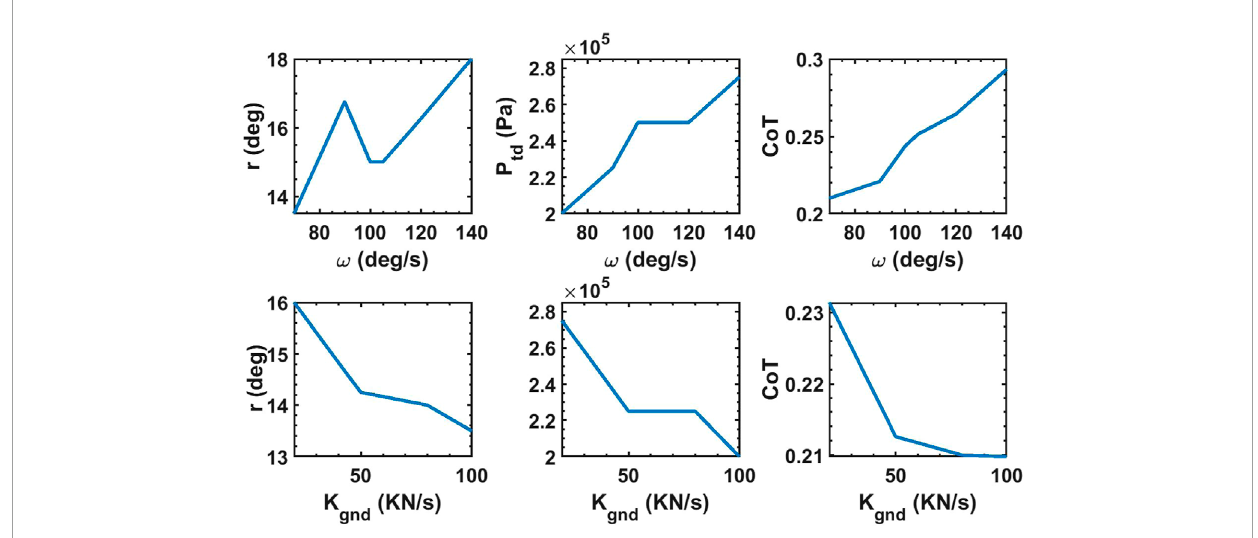
FIGURE 4 Top three plots display the optimum values of stride angle, touchdown pressure and CoT when the robot trots on uneven grounds with K gnd = 100 kN/m and mean slope of zero with various hip/shoulder angular velocity. Bottom three plots display the optimum values of stride angle, touchdown pressure and CoT when the robot trots with ω = 70 deg/s on uneven grounds with various ground stiffness and mean slope of